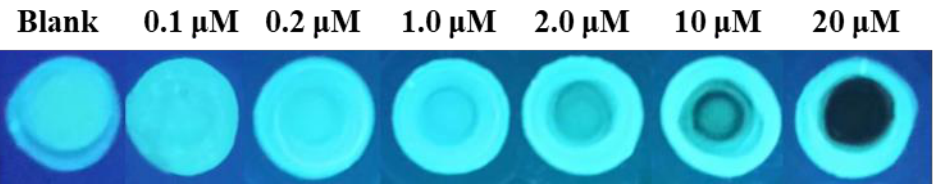
Figure 5. Fluorescent photographs of compound 3 with and without TNP solution on the TLC plate under 365 nm UV light.